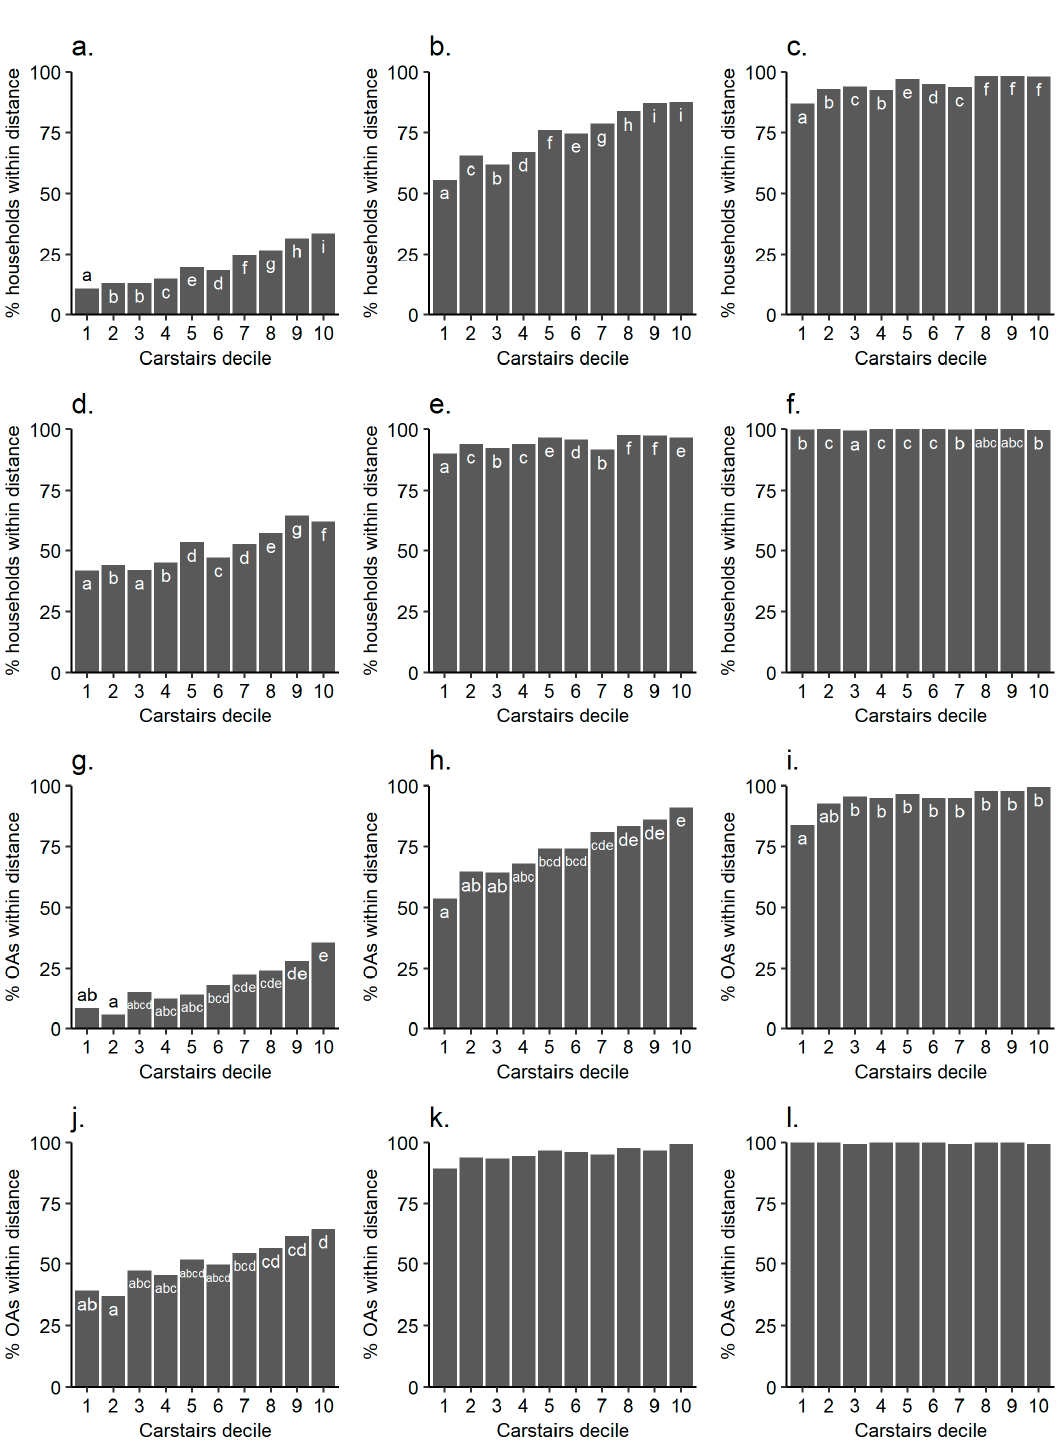
Figure 3. Variation in greenspace accessibility by decile of Carstairs Deprivation Index. Accessibility quantified at household scale by network analysis at 100 m (a), 300 m (b) and 500 m (c) and by straight-line buffer at 100 m (d), 300 m (e) and 500 m (f); and at Output Area scale by network analysis at 100 m (g), 300 m (h) and 500 m (i) and by straight-line buffer at 100 m (j), 300 m (k) and 500 m (l). Different letters indicate significant differences among deciles, e.g., ‘a’ indicates a decile that is significantly different to ‘b’ but not different to other deciles marked ‘a’; while a decile marked ‘ab’ is not significantly different to those marked either ‘a’ or ‘b’ (Tukey’s test at α = 0.05; multiple comparisons are shown only where the overall ANOVA p<0.05 and significant differences were found).